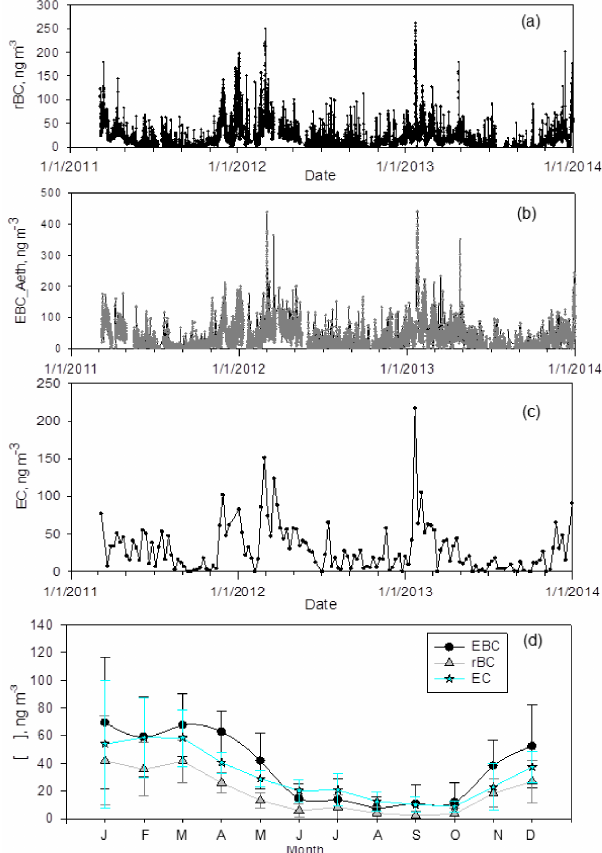
Figure 5. The temporal variation of BC in Alert, NU, from March 2011 to December 2013: (a) hourly refractory BC, (b) hourly equiv- alent BC from the Aethalometer at 880nm, (c) weekly EC concen- trations, and (d) monthly averaged mass of each technique and stan- dard